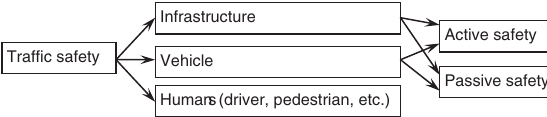
Fig. 1. The factors determining traffic safety